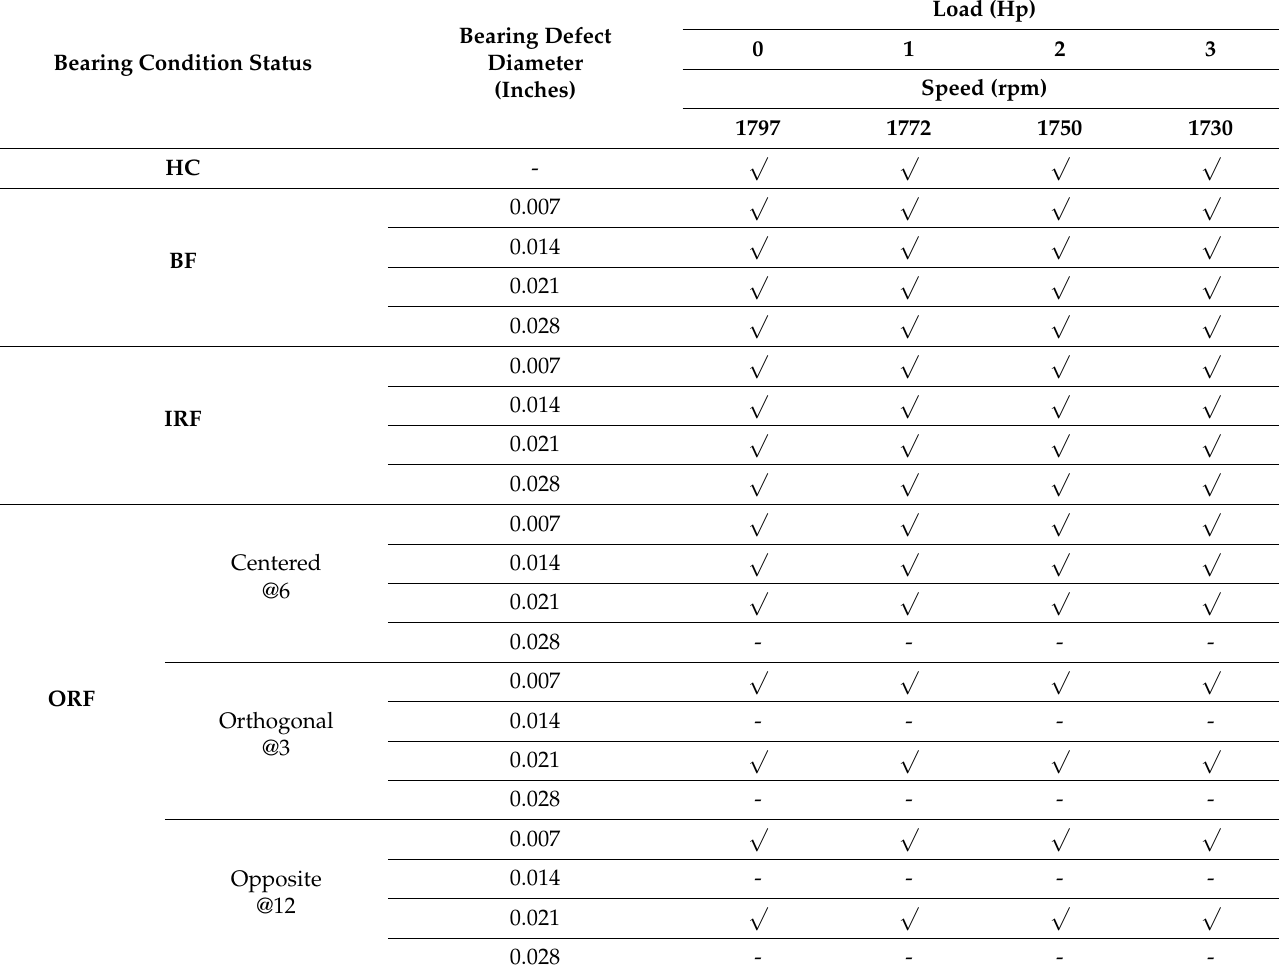
Table 1. Analytical data description of the CWRU